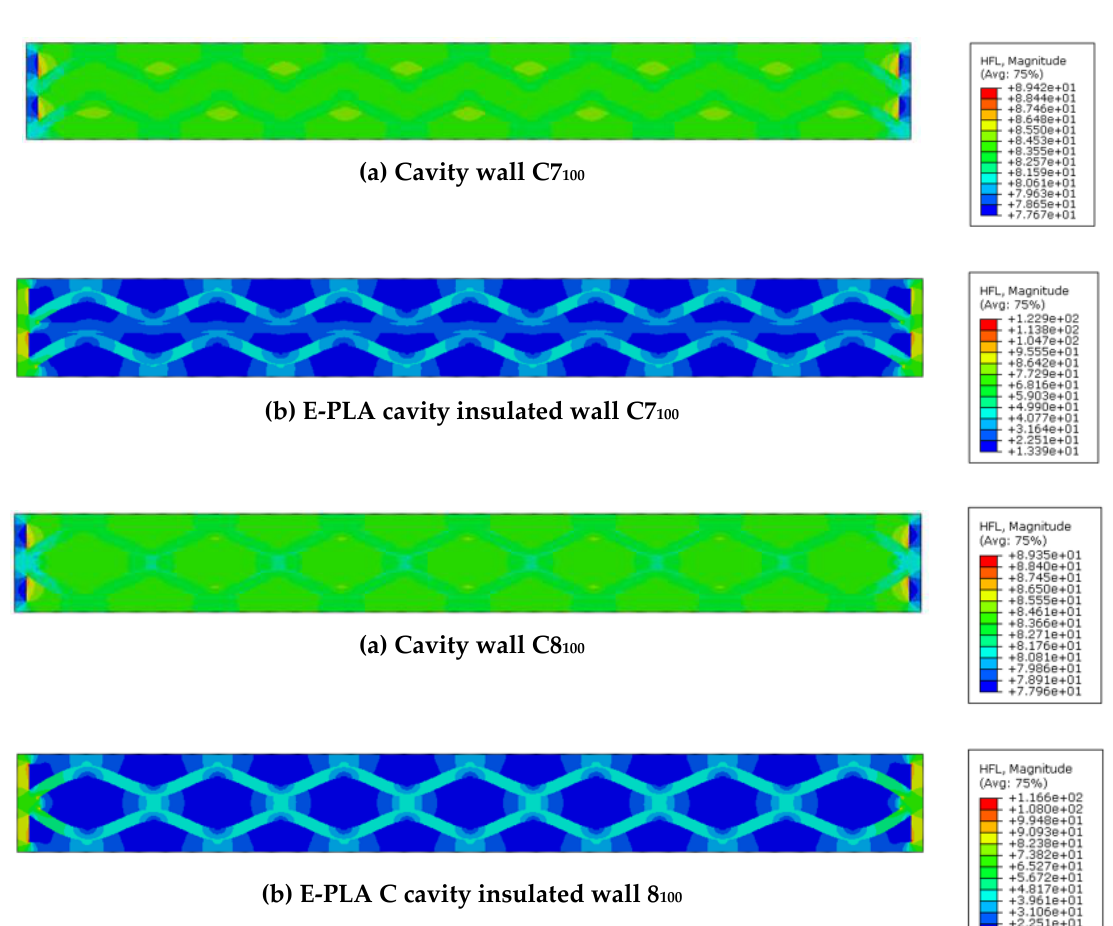
Figure 11. Heat-flux colour distribution along the 100 mm wall configurations.